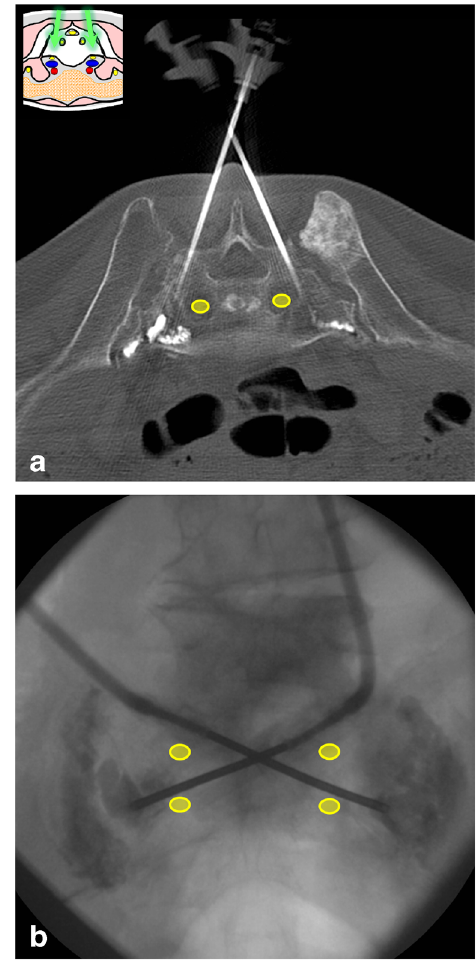
Fig. 23 A 70-year-old woman with metastatic lung cancer and sacral insufficiency fractures. a Axial CTshows the 13-G bone needles inserted in the sacral wings and the beginning of the cement injection. b PA fluoroscopy view is essential to appreciate the real-time cement distribu- tion and confirms the filling of the fracture lines on both sides. Special attention should be paid for sacral foramina during this procedure